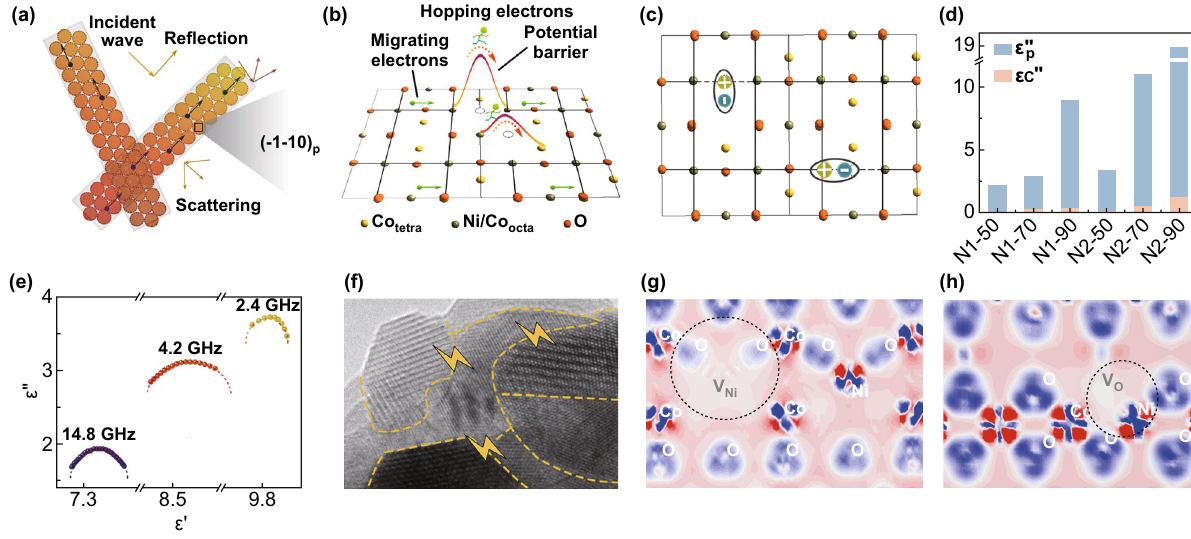
Fig. 4 EM attenuation mechanism of NiCo 2 O 4 nanofibers. a Multiple reflection and scattering. b Conductive network and charge transport. c Polarization induced by defects. d The contribution of ε p ′′ and ε c ′′ to ε ′′ . The suffixes − 50, − 70, and − 90 represent the loading concentration of the composites. e Cole–cole curves of 50 wt% N1. f Interfacial polarization observed from TEM image. g, h Difference charge density around Ni vacancy ( V Ni ) and oxygen vacancy ( V O